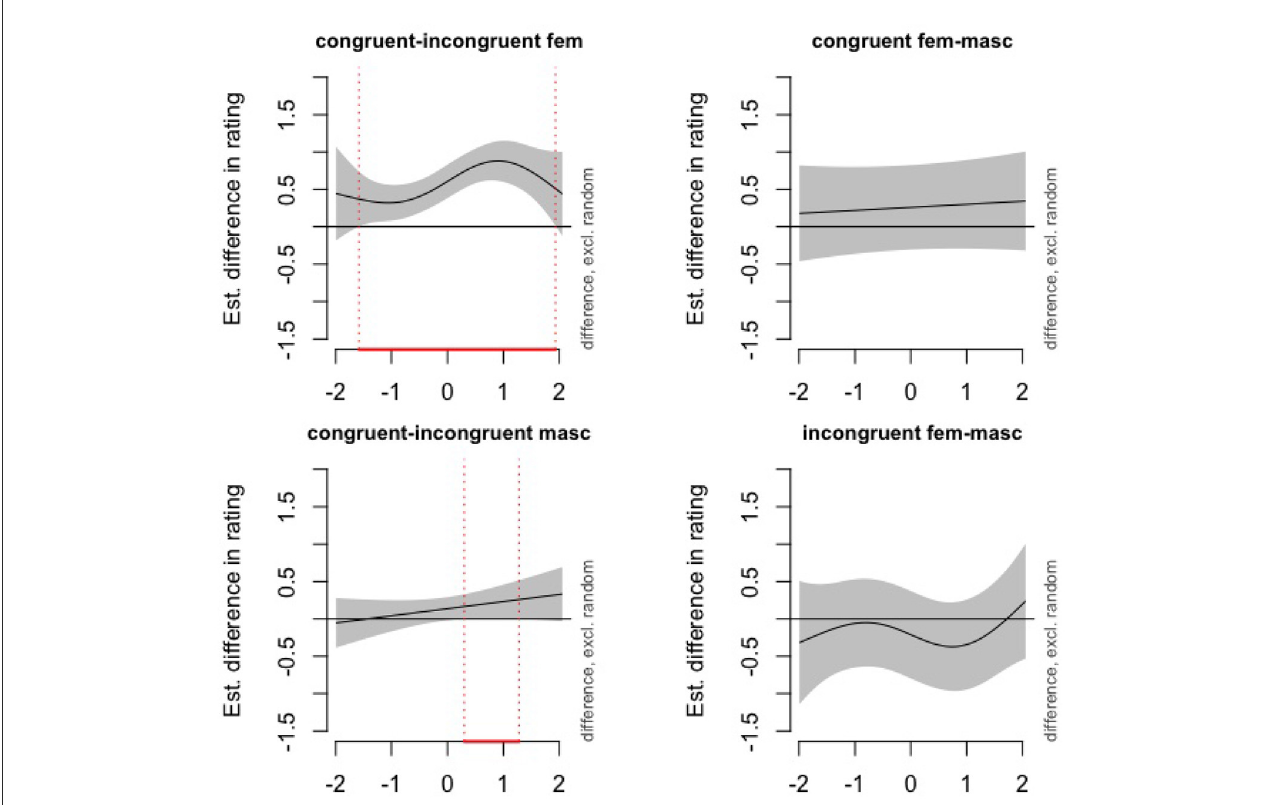
FIGURE4 Empathy: Difference plots depicting the interaction between empathy and stereotype congruence. More negative/positive values on the x-axis indicate lower/higher empathy. (Upper left) Congruent minus incongruent female stereotyped role name; (Upper right) congruent female minus congruent male stereotyped role name; (Lower left) congruent minus incongruent male stereotyped role name; (Lower right) congruent female minus incongruent female stereotyped role name. Vertical, red, dotted lines indicate the area of significant